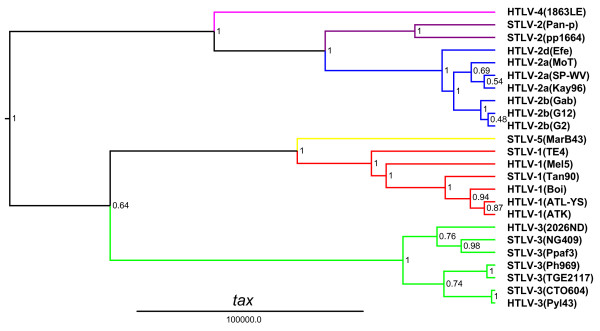
Phylogenetic relationship of HTLV-4(1863LE) to other PTLVs tax using Bayesian inference. First and second codon positions of tax sequences were used to generate PTLV phylogenies by sampling 10,000 trees with a Markov Chain Monte Carlo method under a relaxed clock model, and the maximum clade credibility tree, i.e. the tree with the maximum product of the posterior clade probabilities, was chosen. Branch lengths are proportional to median divergence times in years estimated from the post-burn in trees with the scale at the bottom indicating 100,000 years. Posterior probabilities for each node are indicated. Branches leading to PTLV-1, HTLV-2 and PTLV-3 sequences are drawn in red, blue and green respectively. The branch leading to HTLV-4(1863LE), STLV-2, and to the divergent MarB43 strain are drawn in magenta, purple, and yellow respectively.